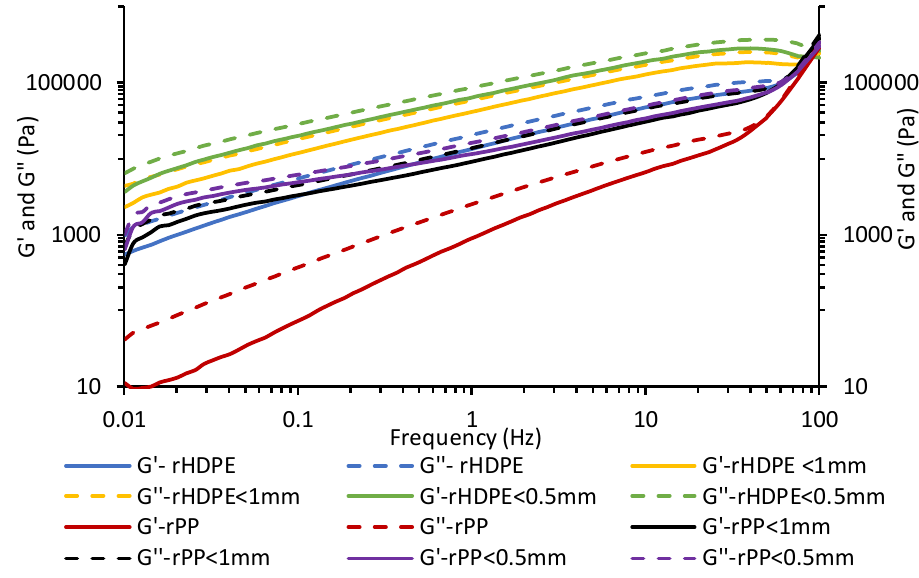
Figure 7. Dynamic rheological measurements (G’ and G”) of polyolefins and rice hull composites.